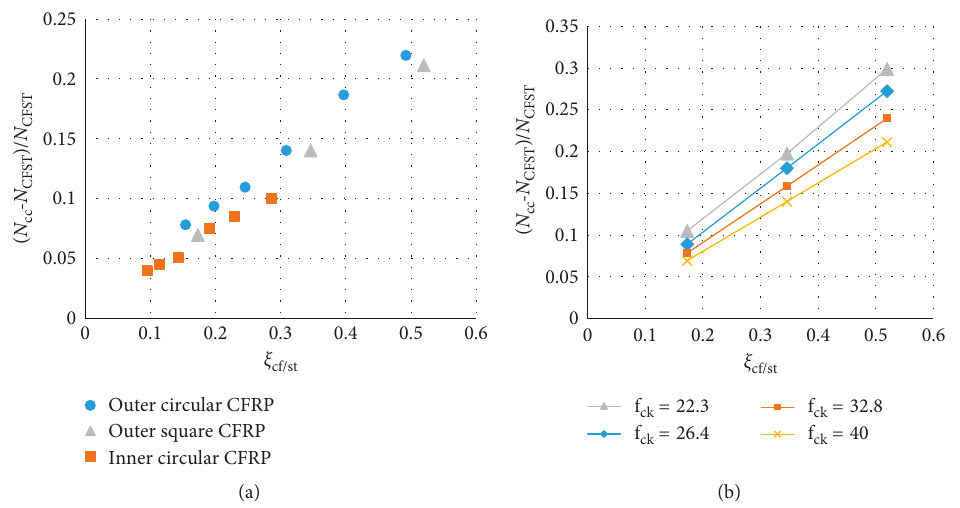
Figure 3: Relationship between ( N